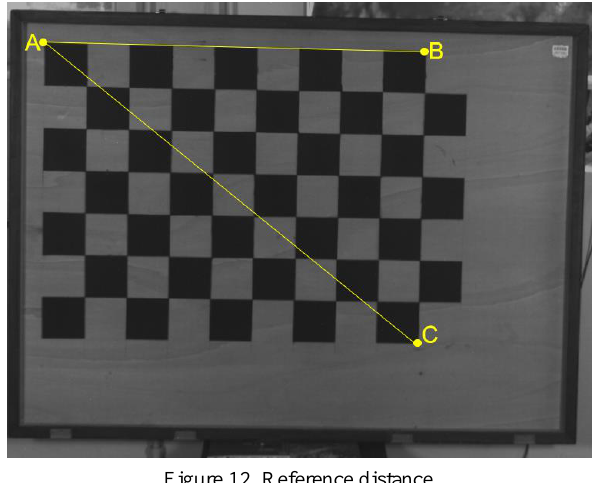
Figure 12 Reference